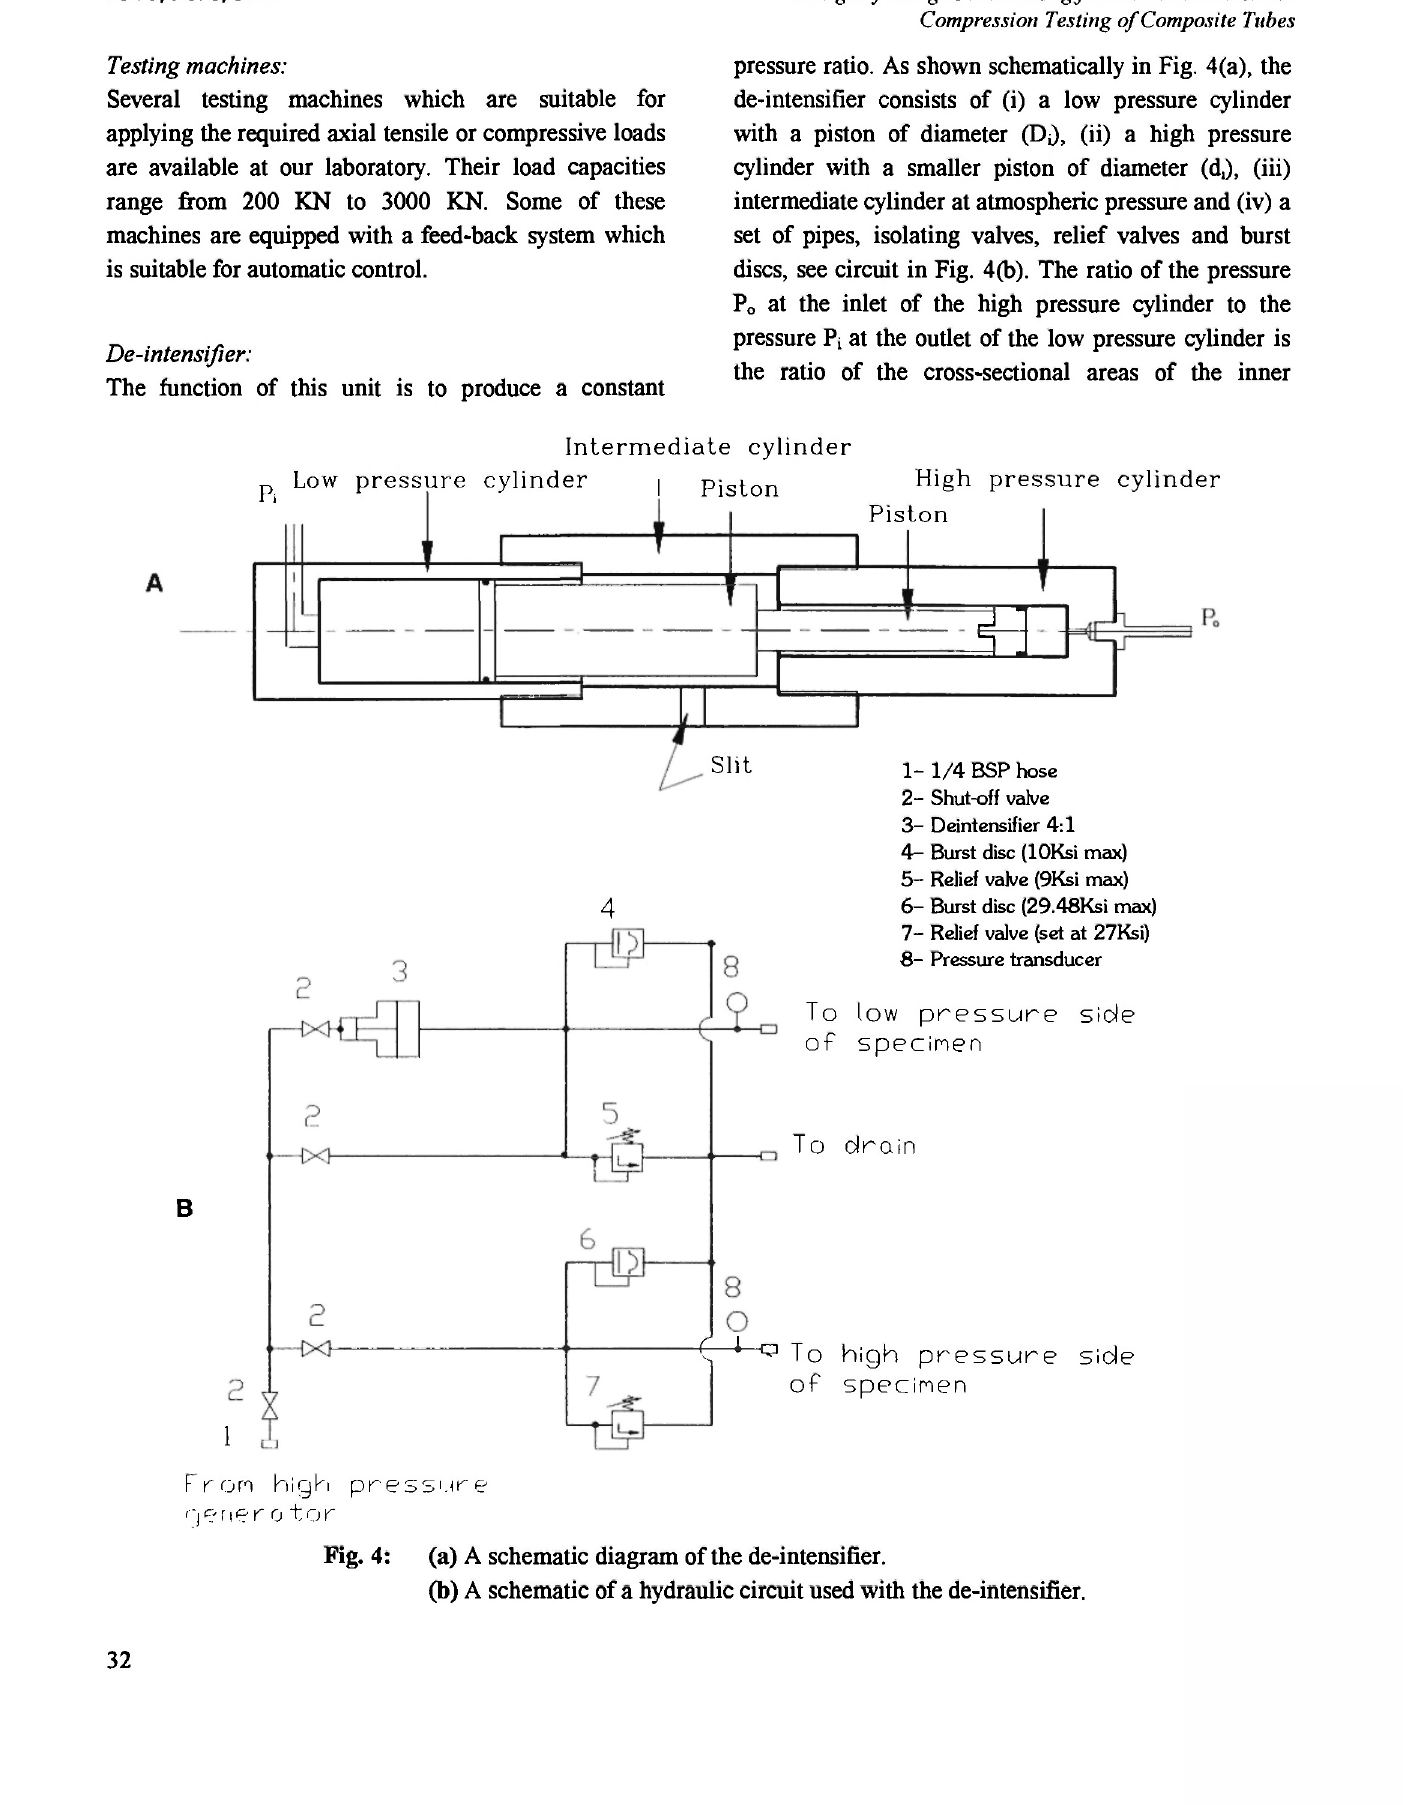
Fig. 4: (a) A schematic diagram of the de-intensifier. (b) A schematic of a hydraulic circuit used with the